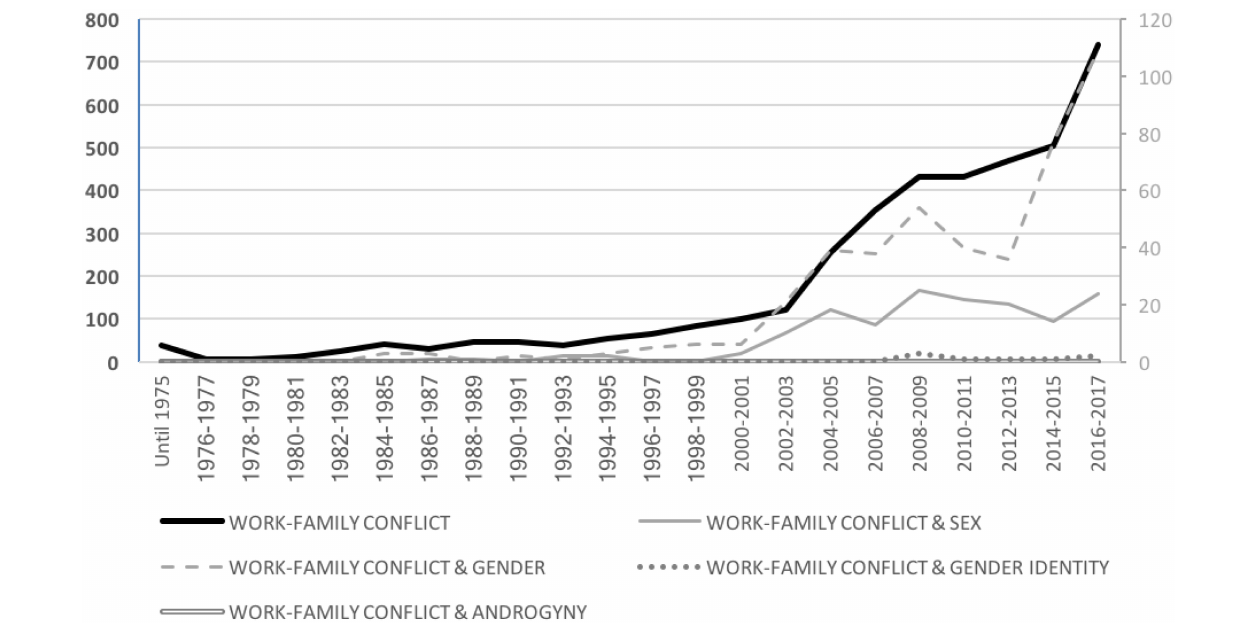
Frontiers in Psychology |